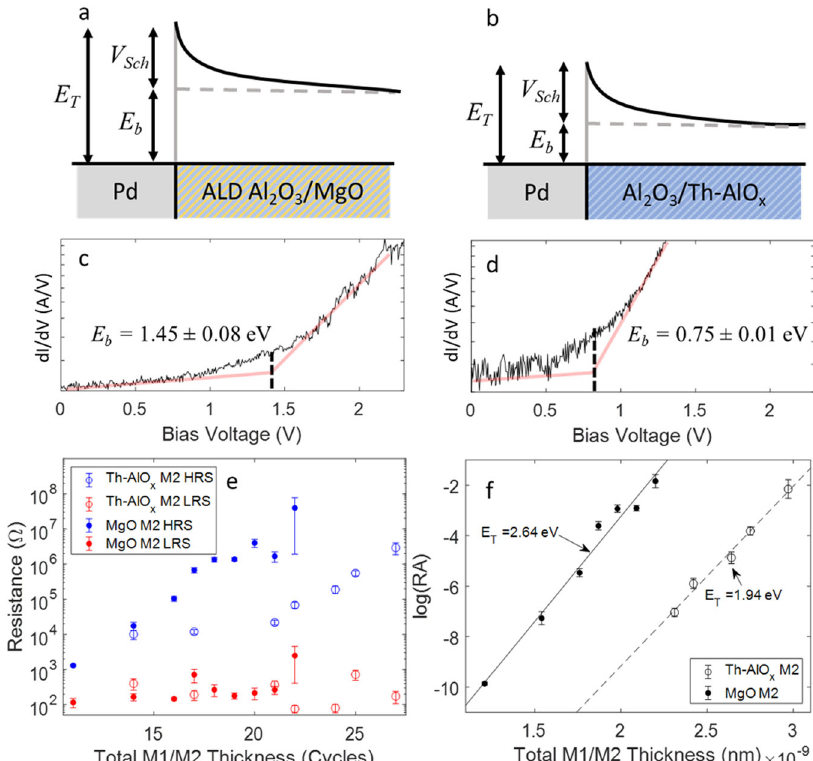
Fig. 6 Effect of tunnel barrier height and Schottky barrier height. Hypothetical barrier energy diagrams at the Pd Schottky interface for a an MgO/Al 2 O 3 memristor, and b an Al 2 O 3 /thermal aluminum oxide (Th – AlO x ) memristor, where E b is the tunnel barrier height, V Sch is the Schottky barrier height, and E T is the combined total barrier height. Representative scanning tunneling spectroscopy dI/dV spectra of c 9C MgO/Al 2 O 3 mix grown without an interfacial layer (Average E b = 1.45 ± 0.08 eV) d 10C Al2O3 grown with an interfacial layer (Average E b = 0.75 ± 0.01 eV). c Comparison of memristor high resistance state (HRS)/low resistance state (LRS) values for memristors with defective oxide (M2) layers composed of ALD-MgO or ThAlO x . d log (RA) fi tting used to fi nd total barrier height E T for memristors with the two different M2 layers. Error bars in e are produced from the standard error of multiple measured devices, while data in f is derived using this HRS standard error and propagating the error to the log (RA)